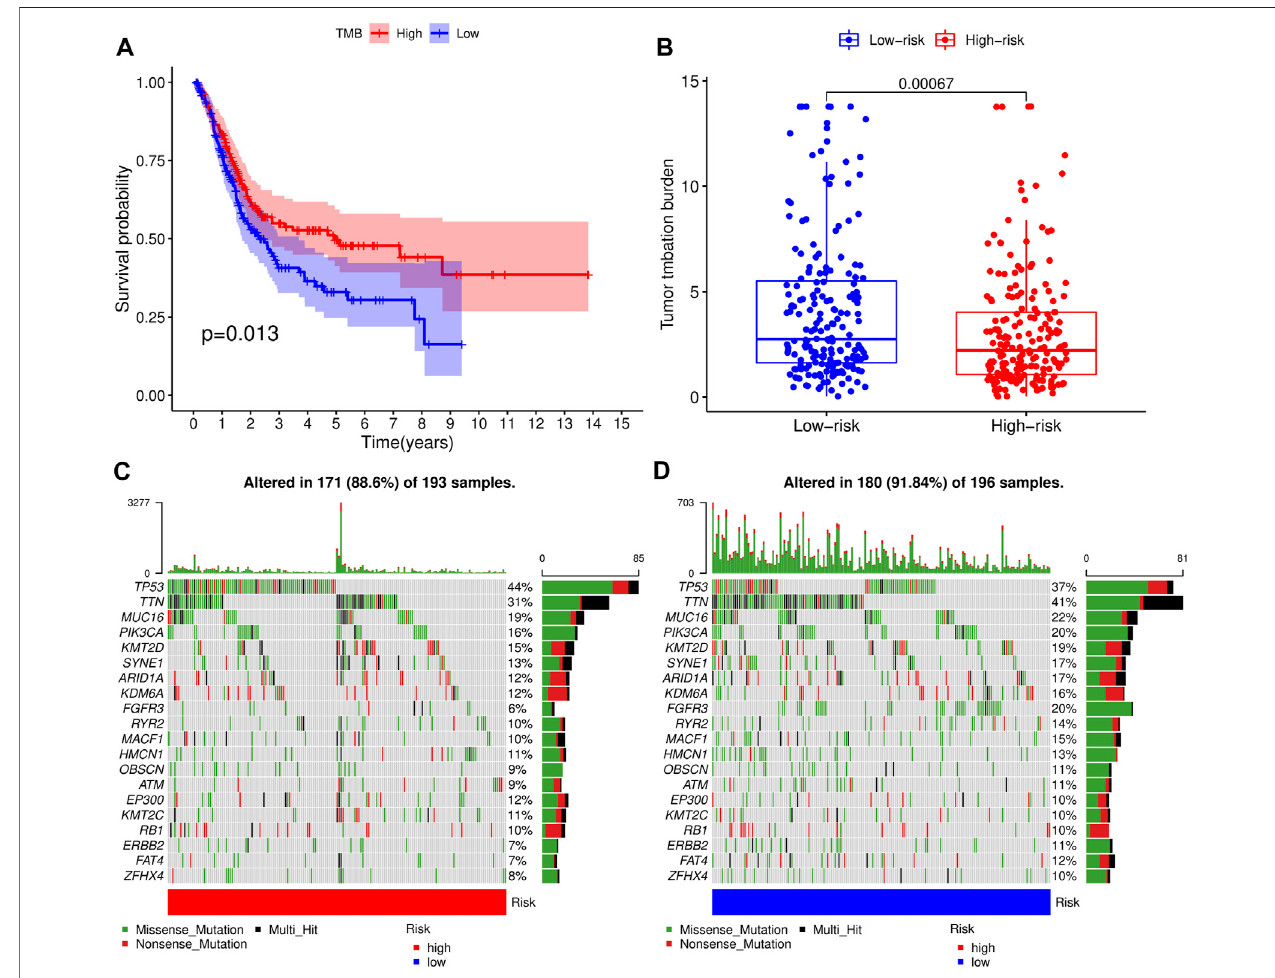
FIGURE 7 | Correlation analysis of tumor mutational load (TMB) and risk scores (RSs). (A) Survival analysis for patients with high- and low-TMB. (B) Difference of TMBlevelbetweenhigh-andlow-RSgroups. (C) Waterfallplotofthetop20 TMB-relatedgenesinthehigh-RSgroup. (D) Waterfallplotofthetop20 TMB-relatedgenes in the low-RS